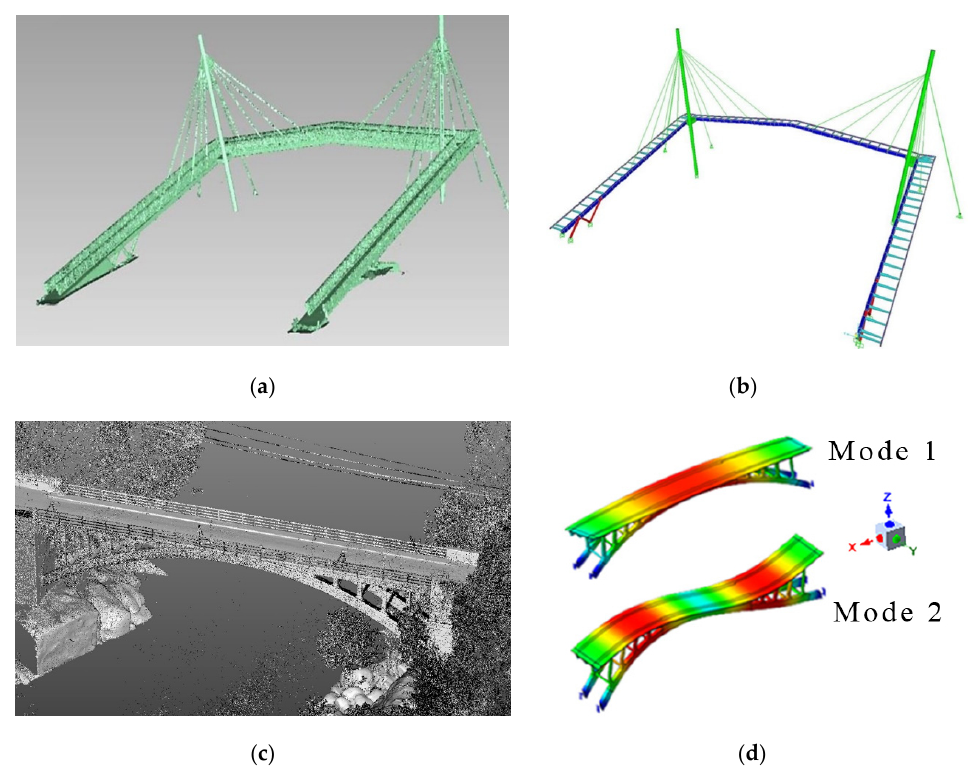
Figure 9. Generation of finite element model from data points for subsequent numerical evaluation: ( a ) optimized acquired point cloud of the footbridge [156]; ( b ) structural finite element model of the footbridge [156]; ( c ) optimized acquired point cloud of the Boco bridge [157]; ( d ) structural modal analysis of the Boco bridge [157].